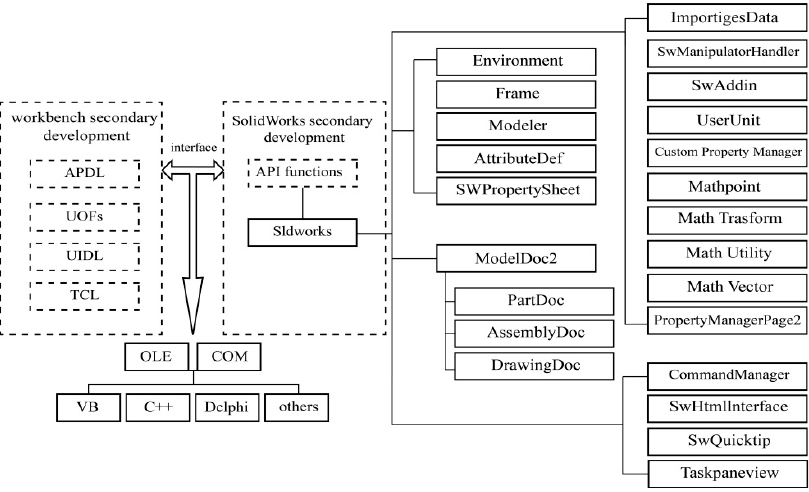
Figure 4. The relation diagram of secondary development method.